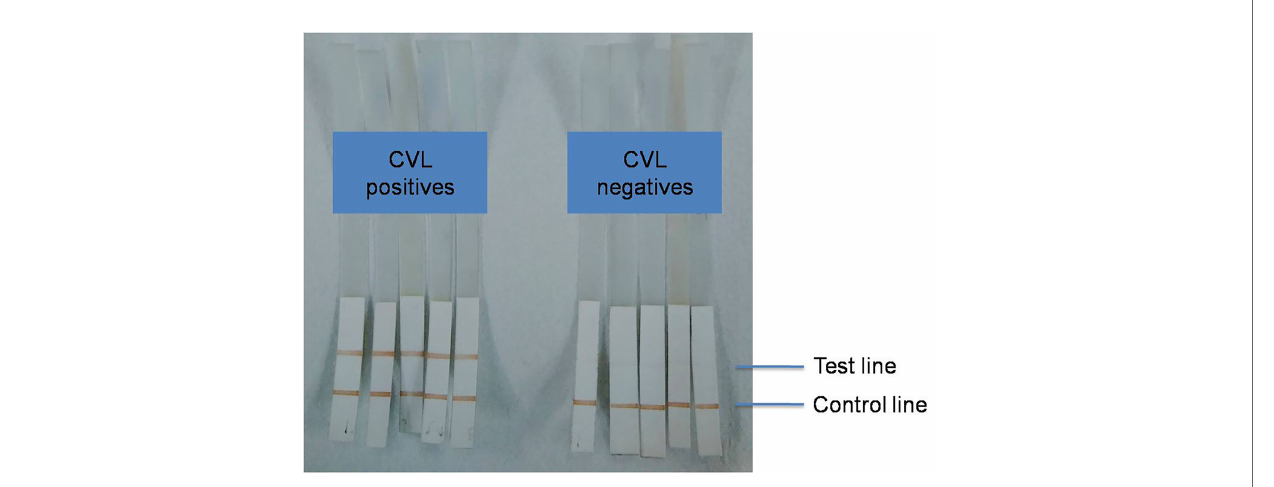
FIGURE 2 | Representative result of dipstick test with positive and negative CVL sera.